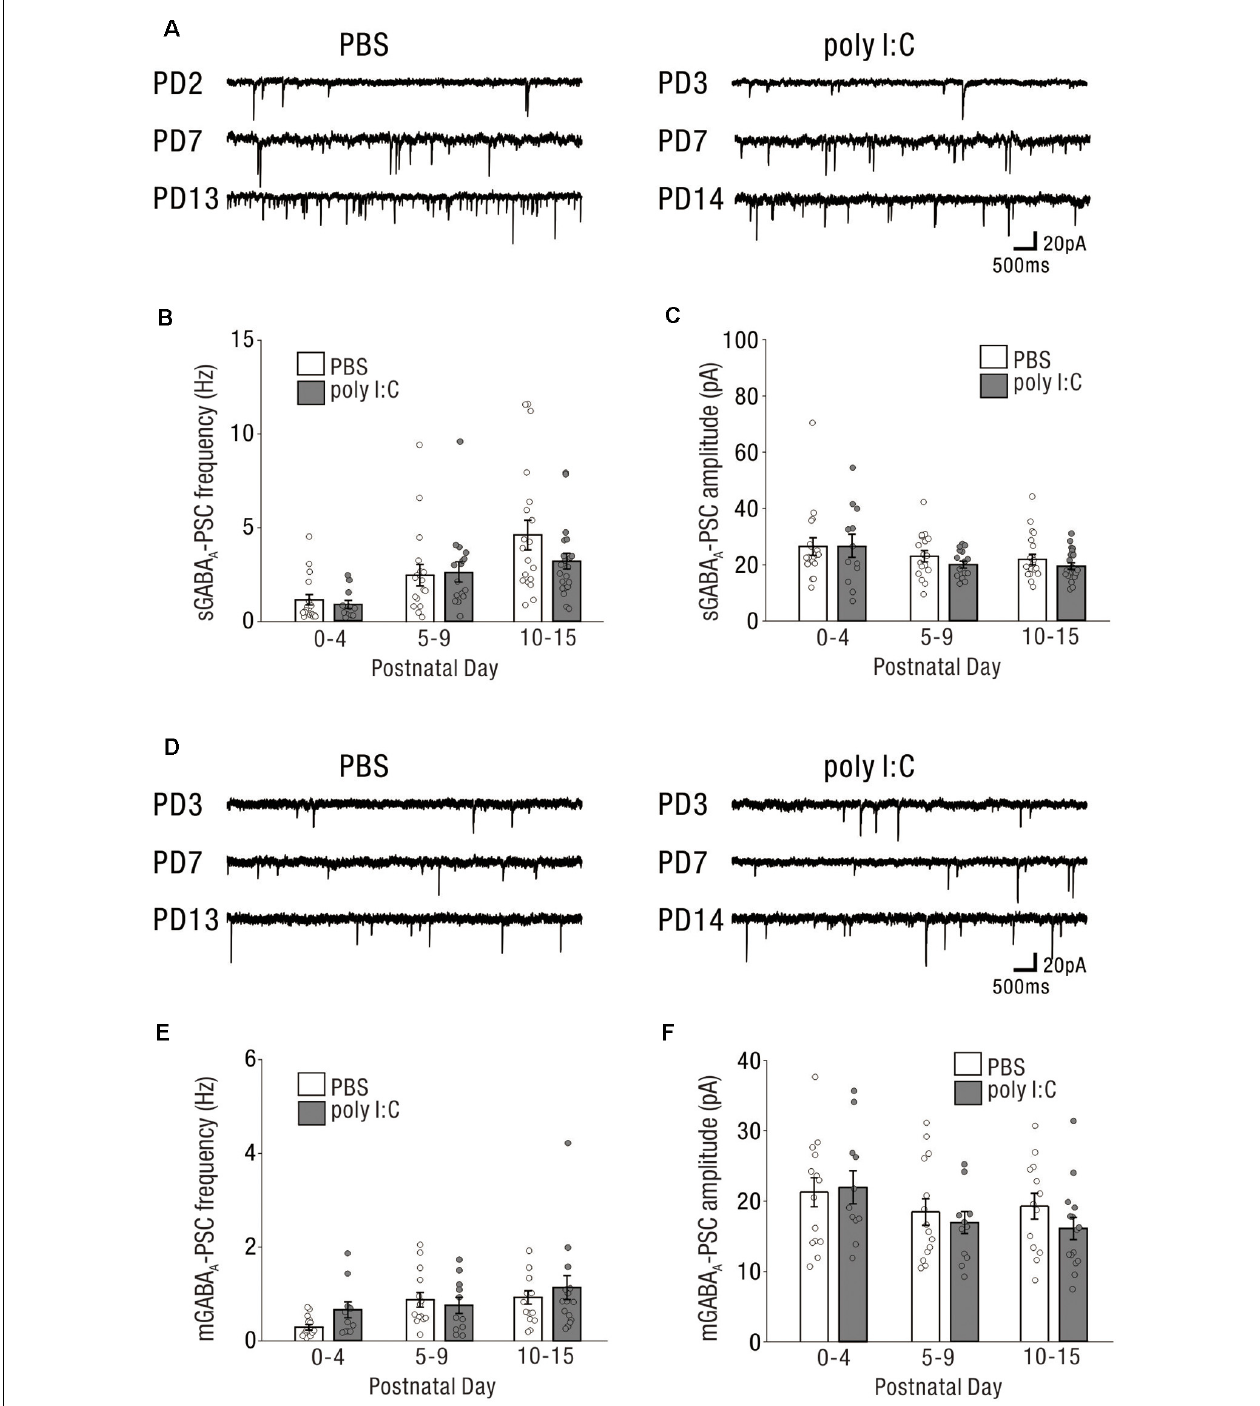
FIGURE 4 | The impact on GABAergic drive and synaptic inputs onto CA1 pyramidal cells in the early postnatal period by prenatal poly I:C treatment are undetected. (A) Representative data of sGABA A -PSCs recorded from a CA1 pyramidal cell of a PBS-treated mouse (left) and poly I:C-treated mouse (right) in each PD during the neonatal period. (B,C) There were no significant differences in sGABA A -PSC frequency and amplitude between PBS-treated and poly I:C-treated mice. (D) Representative data of mGABA A -PSCs recorded from a CA1 pyramidal cell of a PBS-treated mouse (left) and poly I:C-treated mouse (right) in each PD during the neonatal period. (E,F) There were no significant differences in mGABA A -PSCs frequency and amplitude between PBS-treated and poly I:C-treated mice. Poly I:C, polyriboinosinic-polyribocytidilic acid; PBS, phosphate-buffered saline; mGABA A -PSC, miniature GABA A receptor-mediated postsynaptic current; sGABA A -PSC, spontaneous GABA A receptor-mediated postsynaptic current.